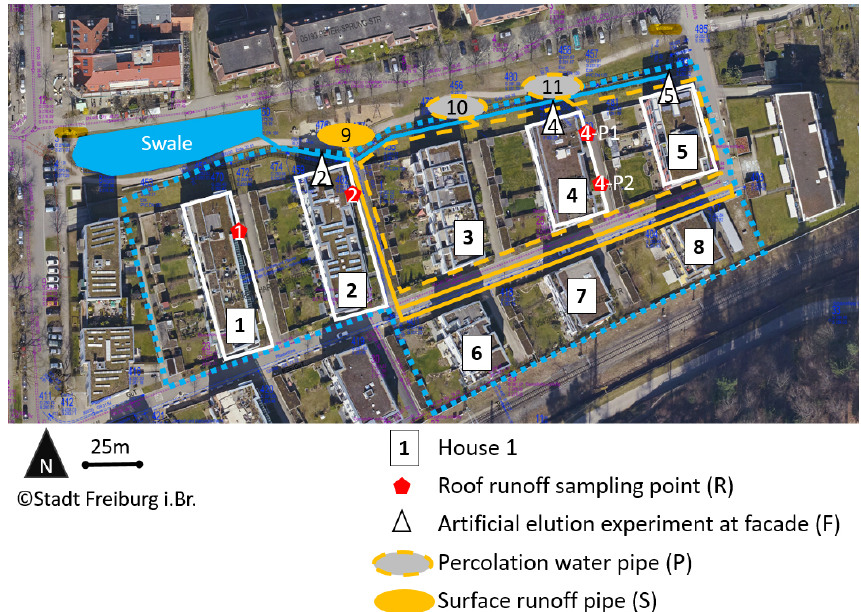
Figure 2. Study area with sampling points and houses (aerial view). White lines indicate investigated houses. The blue dotted line encloses the drainage area connected to the swale. Yellow and dashed yellow lines enclose approximate areas connected to percolation water pipes and surface runoff pipe. Source: Stadt Freiburg i. Br.